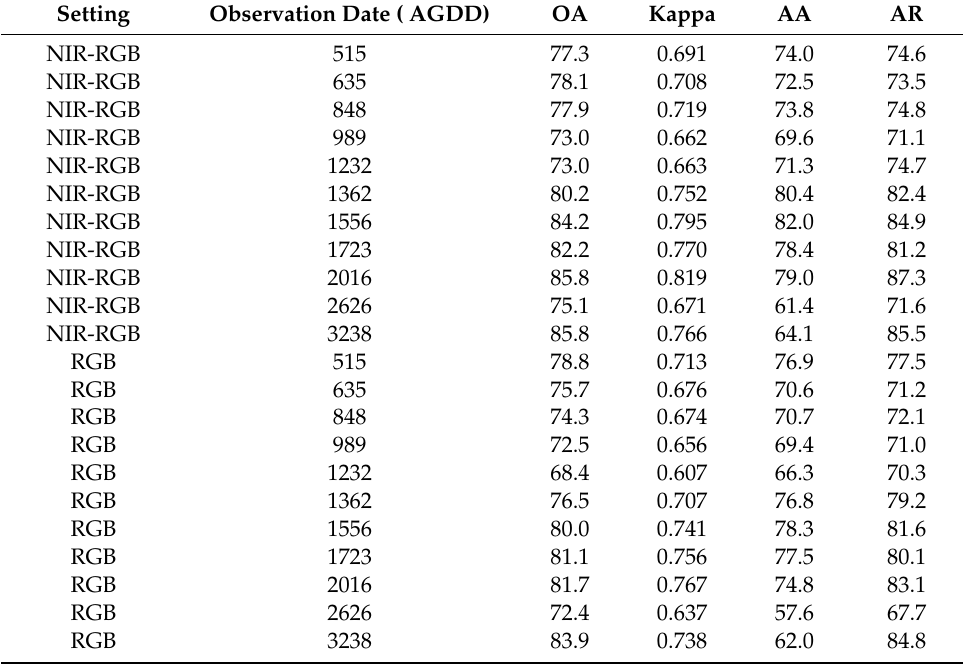
Table A1. Overall accuracy (OA), Kappa coe ffi cient, average accuracy (AA), and average reliability (AR) for both settings and all observation dates.